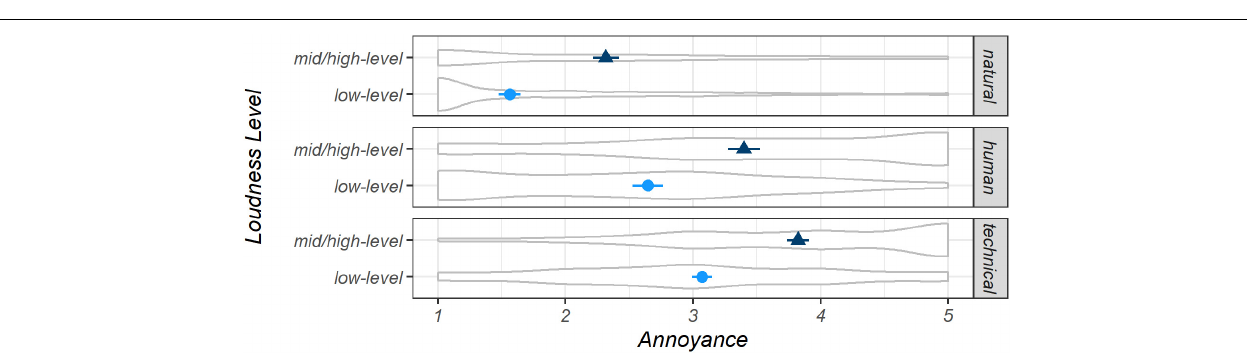
FIGURE 2 | Estimated marginal means for Annoyance for natural , human , and technical sounds, separated by binary Loudness levels, displayed with 95% confidence intervals, both determined by bootstrapping. Very pleasant = 1, very annoying = 5. Distributions of the underlying measured Annoyance judgments are presented in gray. Model Macro2